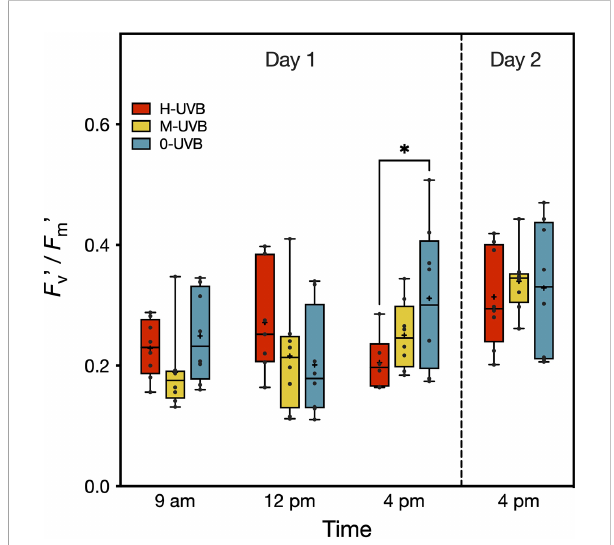
FIGURE 3 Effective quantum yield ( F v ’ / F m ’ ) of Stylophora pistillata fragments, measured during the experiment on 6 th (Day 1) and 7 th October 2016 (Day 2). Coral fragments were incubated in either full UVB (red), medium UVB (yellow), or UVB removal (blue) conditions. Boxplots indicate 95% CIs. The horizontal lines inside the boxplots represent medians, while crosses indicate means (n=8). Tukey ’ s pairwise comparison results are shown above boxplots (* indicates p < 0.05).